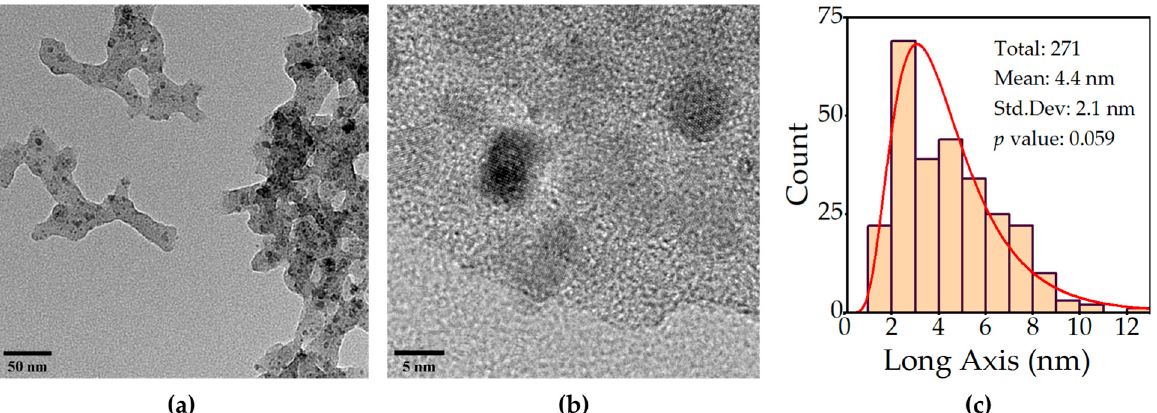
Figure 1. Morphology analysis of nanoparticles grown in silicone. ( a ) Representative TEM image. ( b ) High-resolution TEM image of the nanoparticles. ( c ) Histogram of particle sizes fitted to a lognormal size distribution.